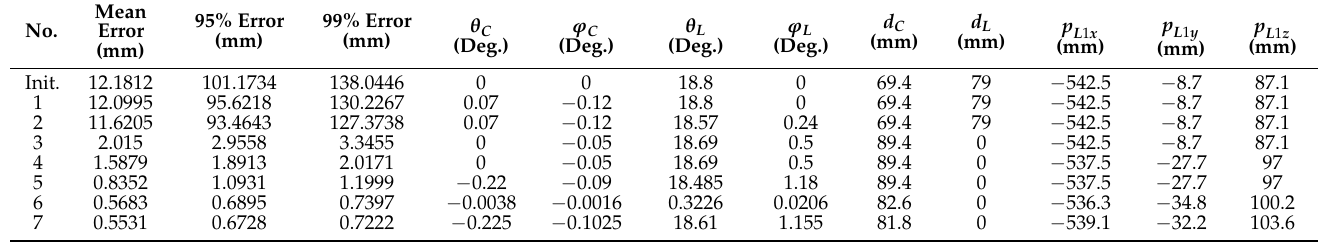
Table 3. Parameter study.